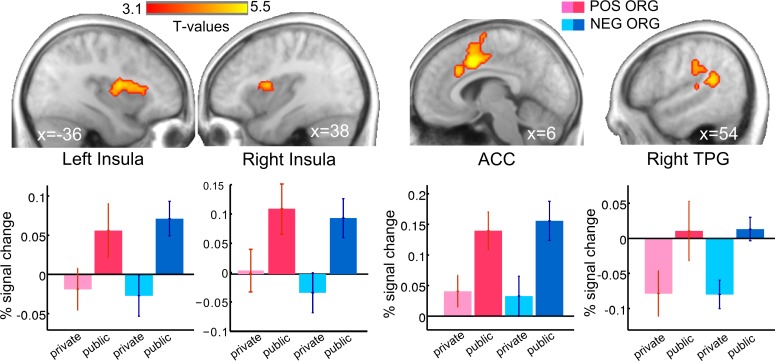
Brain responses in public relative to private.Being observed increased activity in the bilateral INS, ACC, and right TPJ. Activations are overlaid on an average anatomical scan of all subjects (cluster-wise FWE-corrected p < 0.05 and voxel-wise uncorrected p < 0.001). Plots of mean PSCs are shown for illustrative purpose. For the POS ORG and the NEG ORG, respectively, light pink and light blue represent the private trials, while dark pink and dark blue are used for the public trials. Error bars indicate SEM. See S1 Data. fMRI data corresponding to this figure can be found at the following URL: https://neurovault.org/collections/5028/. ACC, anterior cingulate cortex; fMRI, functional MRI; FWE, family-wise error; INS, insula; NEG ORG, negatively valued organization; POS ORG, positively valued organization; PSC, percent signal change; TPJ, temporoparietal junction.